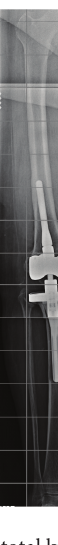
Figure 3: Hinged revision total knee arthroplasty after second stage replacement